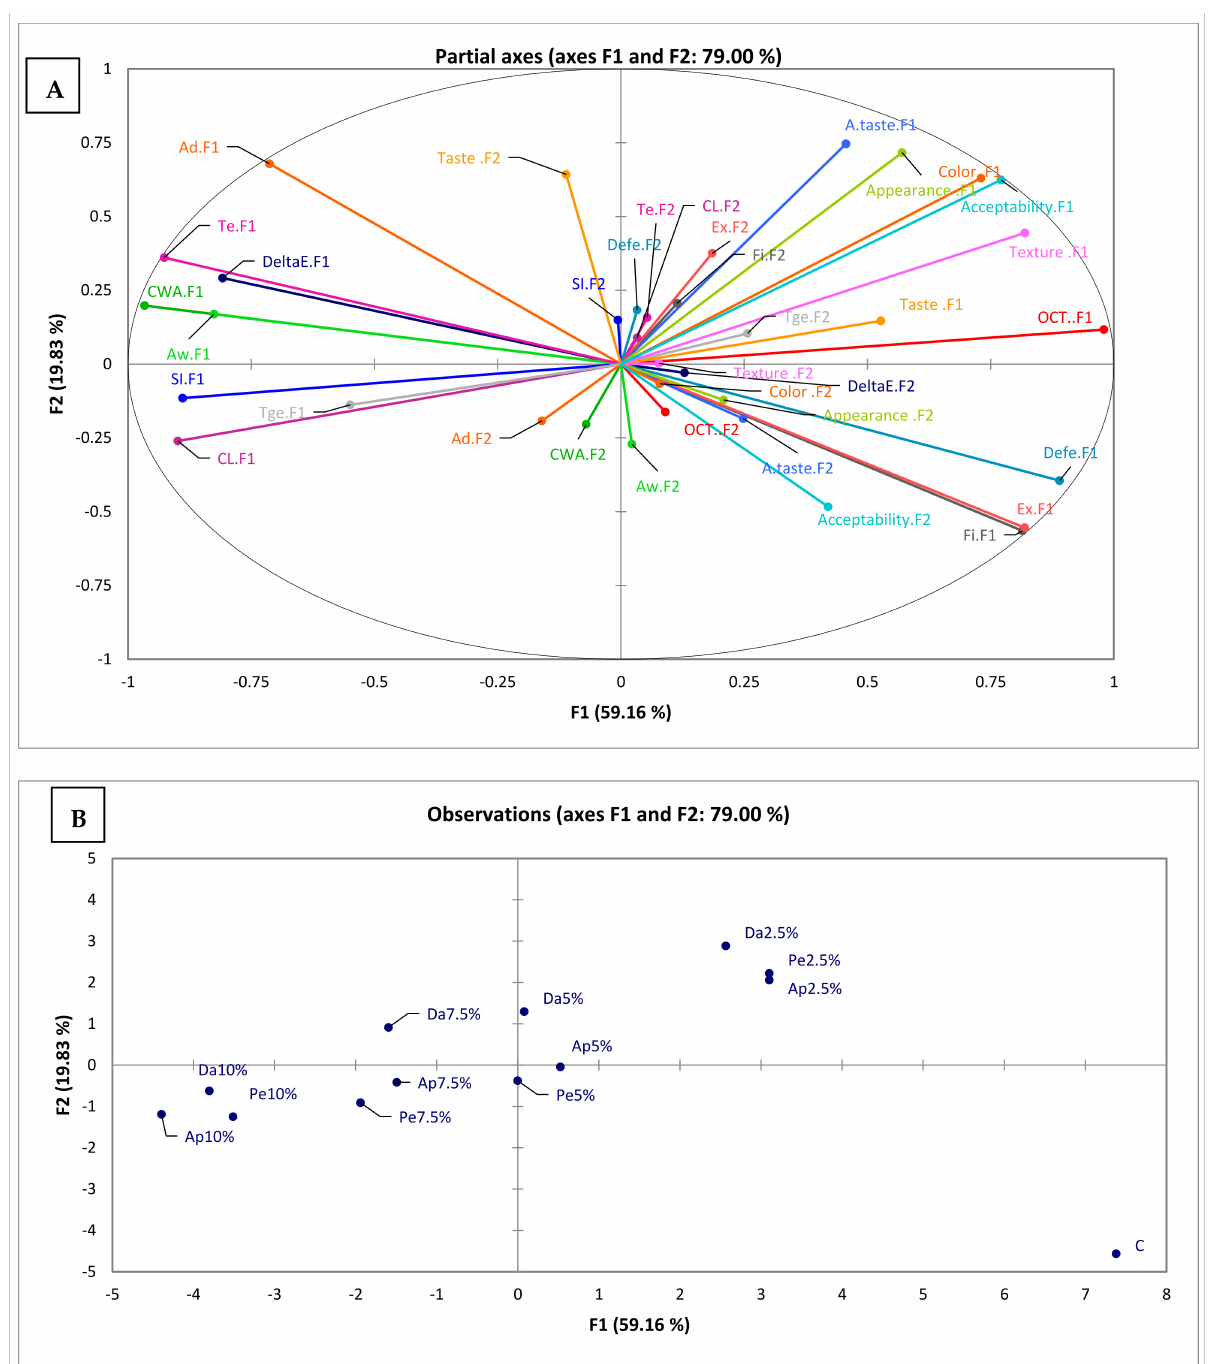
Figure 2. ( A ) The score and loading plots for F1 versus F2 (OCT: optimum cooking time; SI: swelling index; CWA: cooking water absorption; CL: cooking loss; Fi: firmness; Ad: adhesiveness; DeltaE: color difference ( ∆ E); Aw: water activity; Te: tenacity; Ex: extensibility; Defe: deformation energy; and Tge: gelatinization temperature). ( B ) The distribution of different samples in relation to the F1 and F2